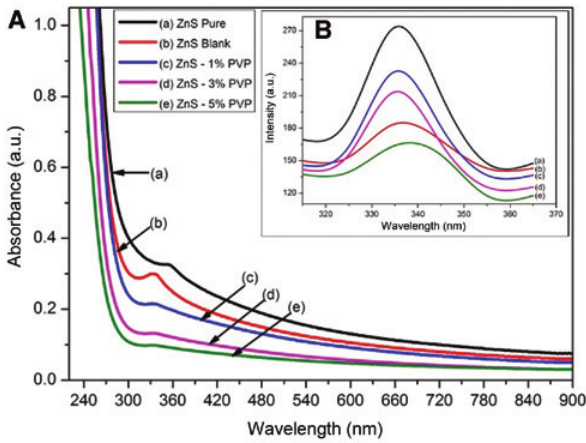
Figure 3: Absorption [A] and emission [B] spectra of the free/ uncapped (a) blank and (b) ZnS nanoparticles capped with (c) 1%, (d) 3%, and (e) 5%